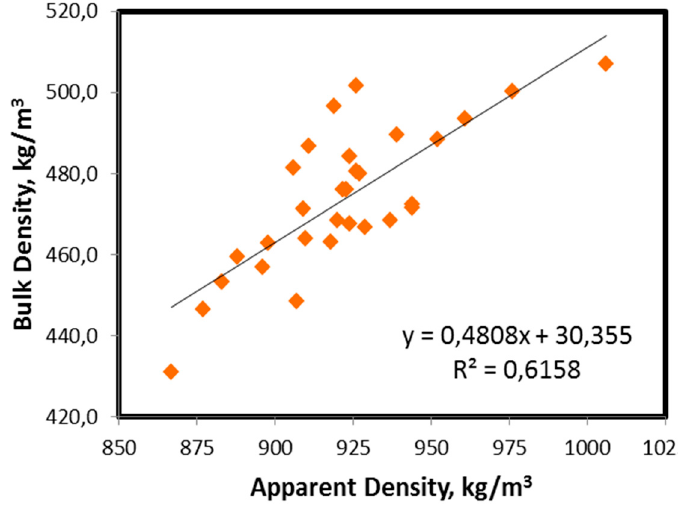
Figure 6. Influence of binder type on apparent density of briquettes.